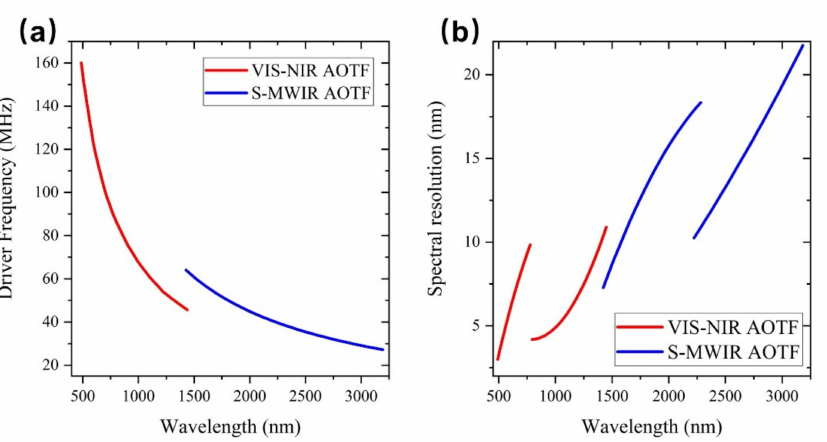
Figure 6. ( a ) The wavelength-frequency tuning curve of the AOTFs in the Chang’e-5 LMS; ( b ) Spectral resolution of the acousto-optic tunable filters vs. wavelength for the Chang’e-5